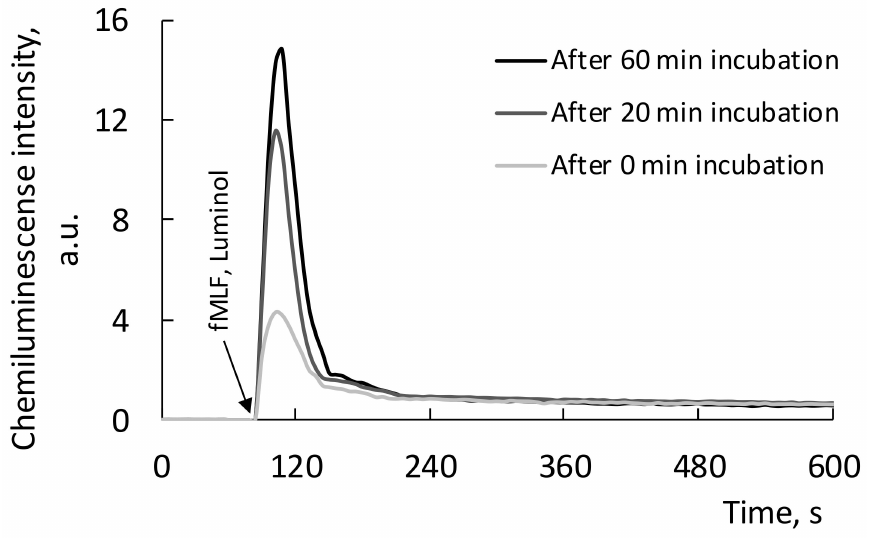
Figure 2. Representative kinetic curves of chemiluminescence in a suspension of neutrophils after the addition of an IFN γ solution distantly pre-incubated with samples of HD Abs to IFN γ . The samples contained: suspension of neutrophils—2.5 × 10 5 cells; an IFN γ solution (10 ng/mL) incubated for 0 min (light grey curve), 20 min (dark grey curve), and 60 min (black curve) in the presence of HD Abs to IFN γ , which constituted 80% of the total sample volume (previously mixed with concentrated Hank’s solution to create normal osmolarity); fMLF (2 µ M); luminol (0.35 mM). Measurements were performed at 37 ◦ C and pH